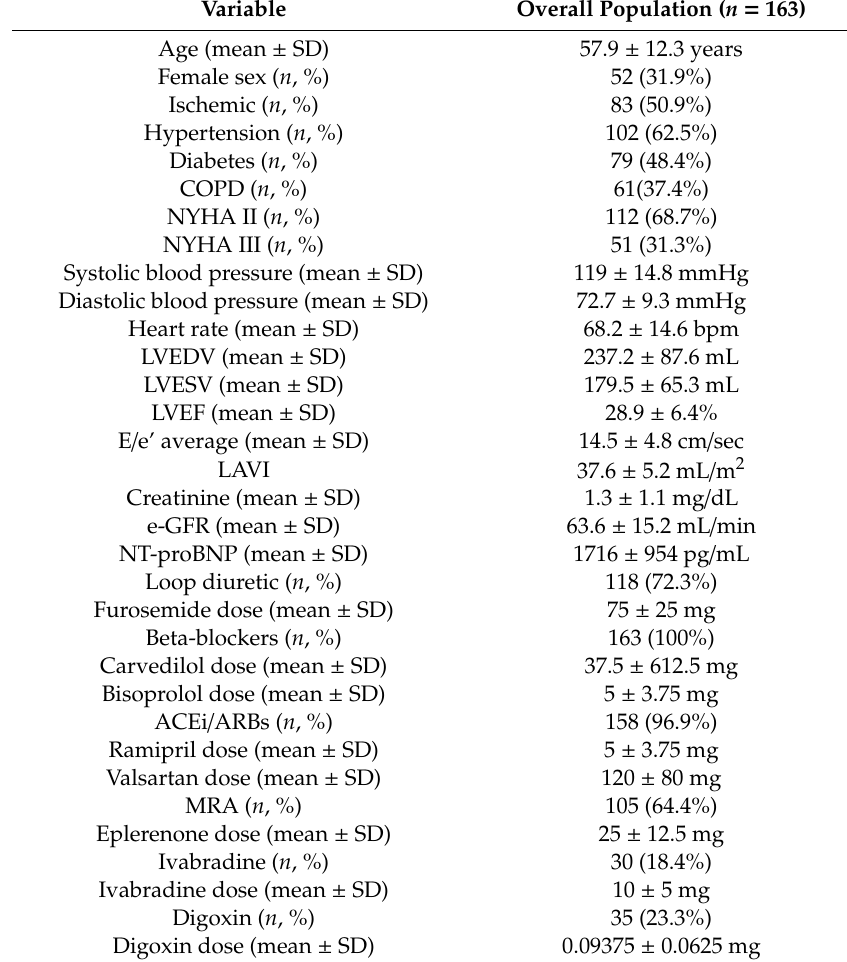
Table 1. Baseline characteristics of the overall